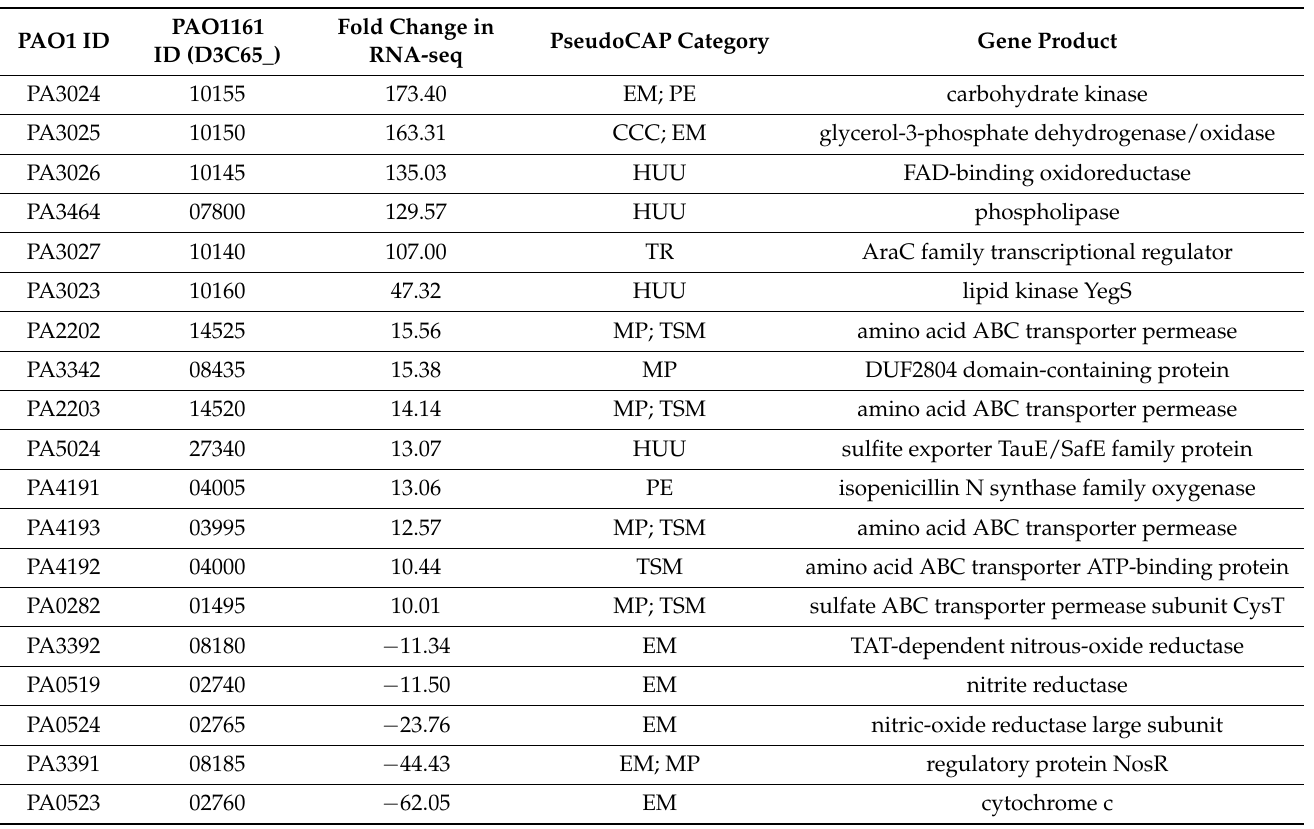
Table 1. Genes with altered expression in response to PA3027 excess (fold change < − 10 or >10). PseudoCAP categories description as in Figure